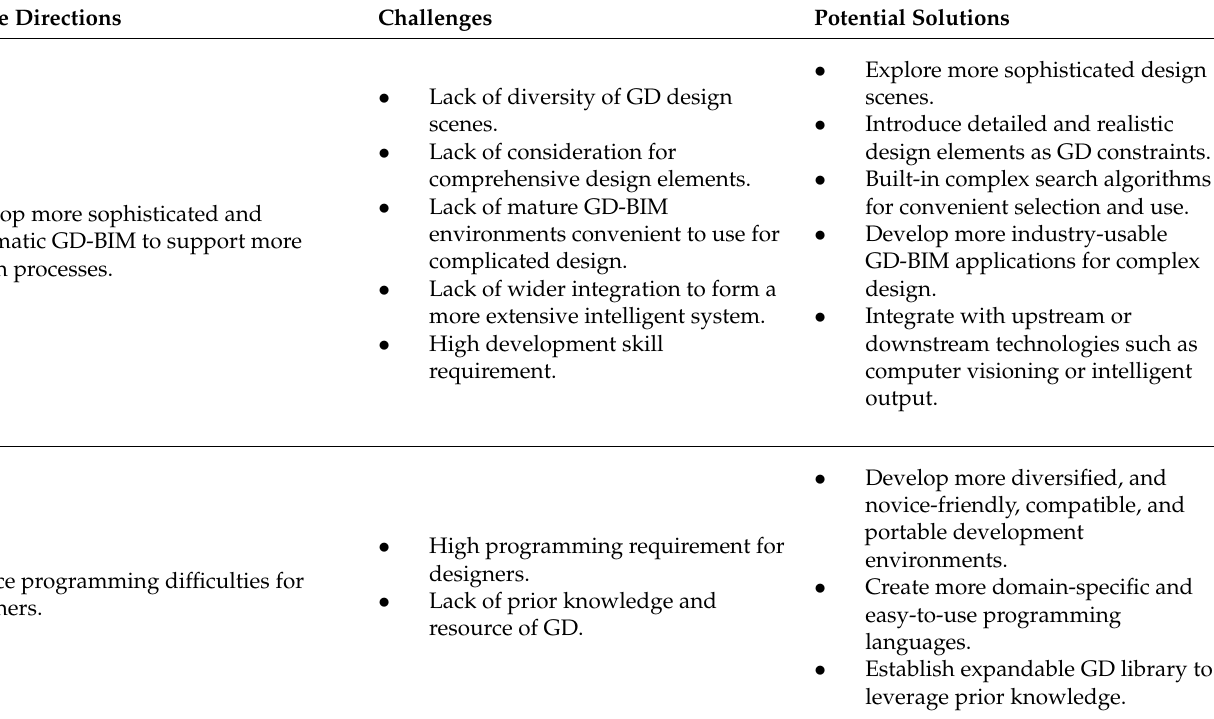
Table 6. Future directions of GD-BIM development and corresponding challenges and potential solutions. Future